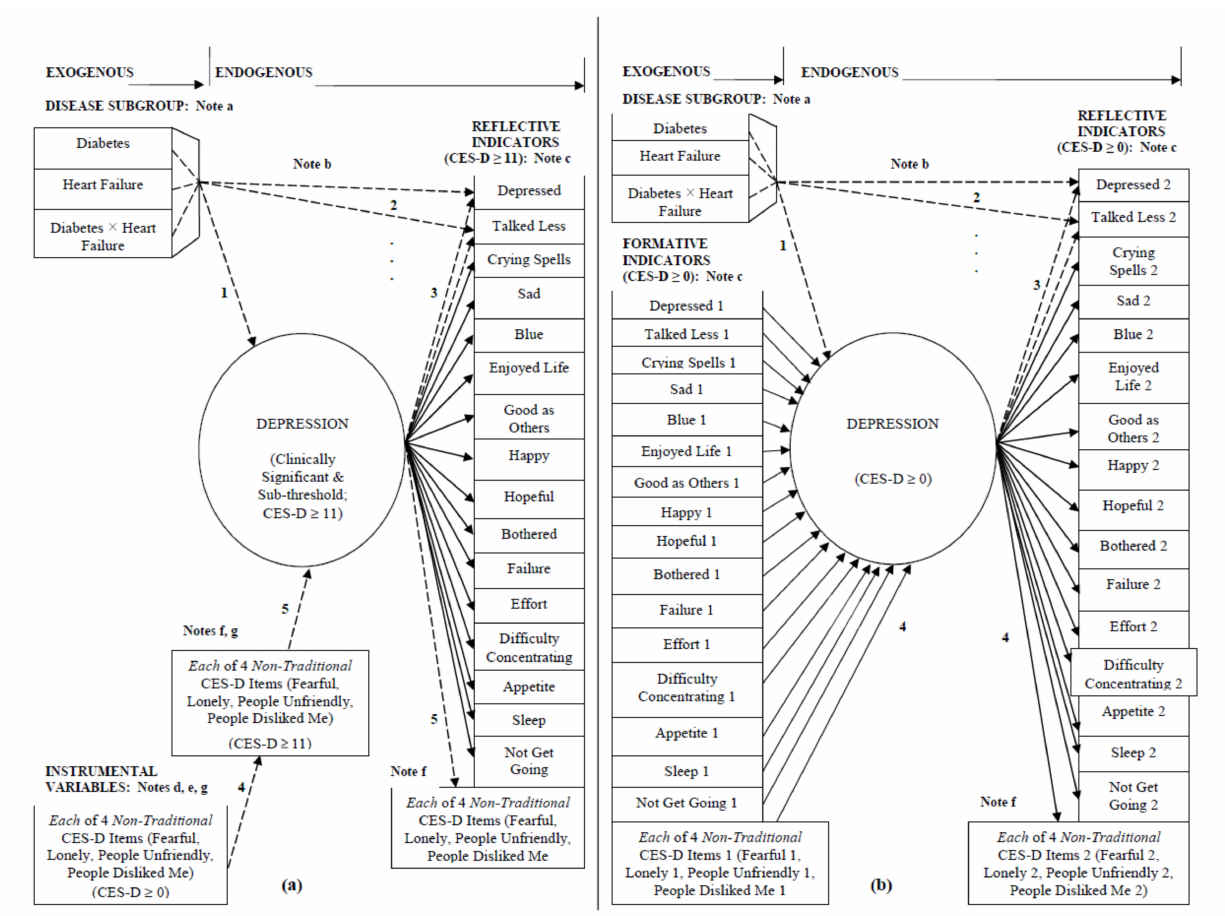
Figure 1. MIMIC Models of Depression with 20 Reflective (Effect) Indicators in Diabetes-Heart Failure Subgroup: ( a ) with Instrumental Variables of 4 Non-Traditional Depression Items; ( b ) with 20 Formative (Causal)